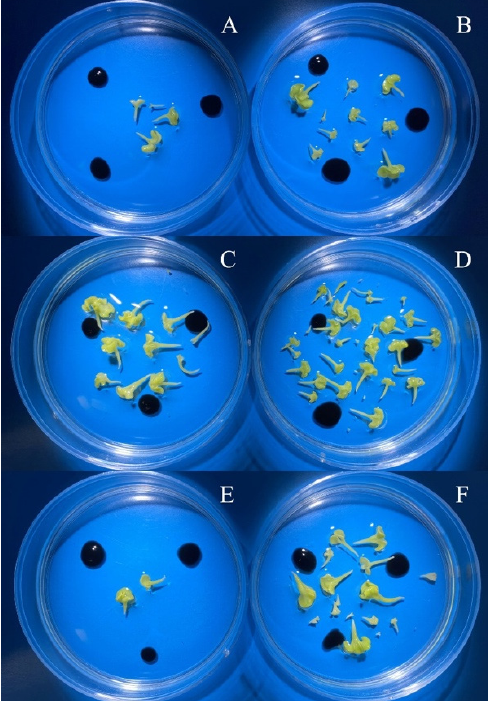
Figure 5. Yield of Sareptian mustard ‘Sudarushka’ embryoids at day 25 of culture depending on the method of isolation and linear size of buds. ( A , C , E )—microspore isolation № 2; ( B , D , F )—microspore isolation № 3; ( A , B )—bud size 2.5–2.9 mm; ( C , D )—bud size 2.9–3.3 mm; ( E , F )—bud size 3.3–3.7 mm.